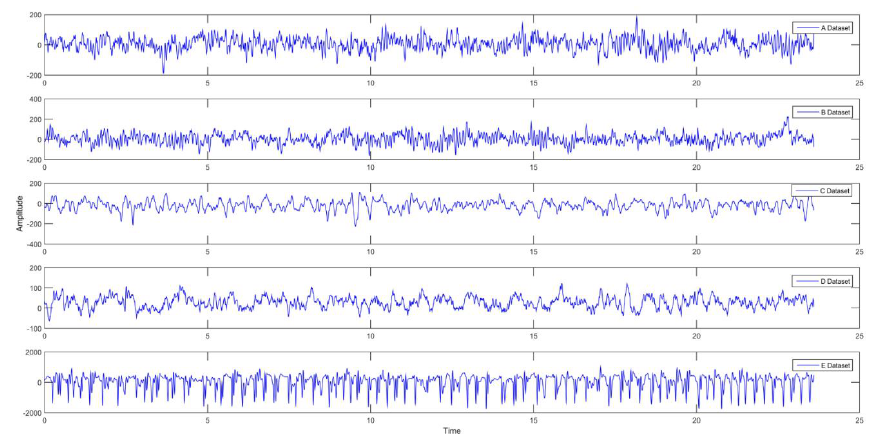
Figure 3. EEG data sets used in this Study.